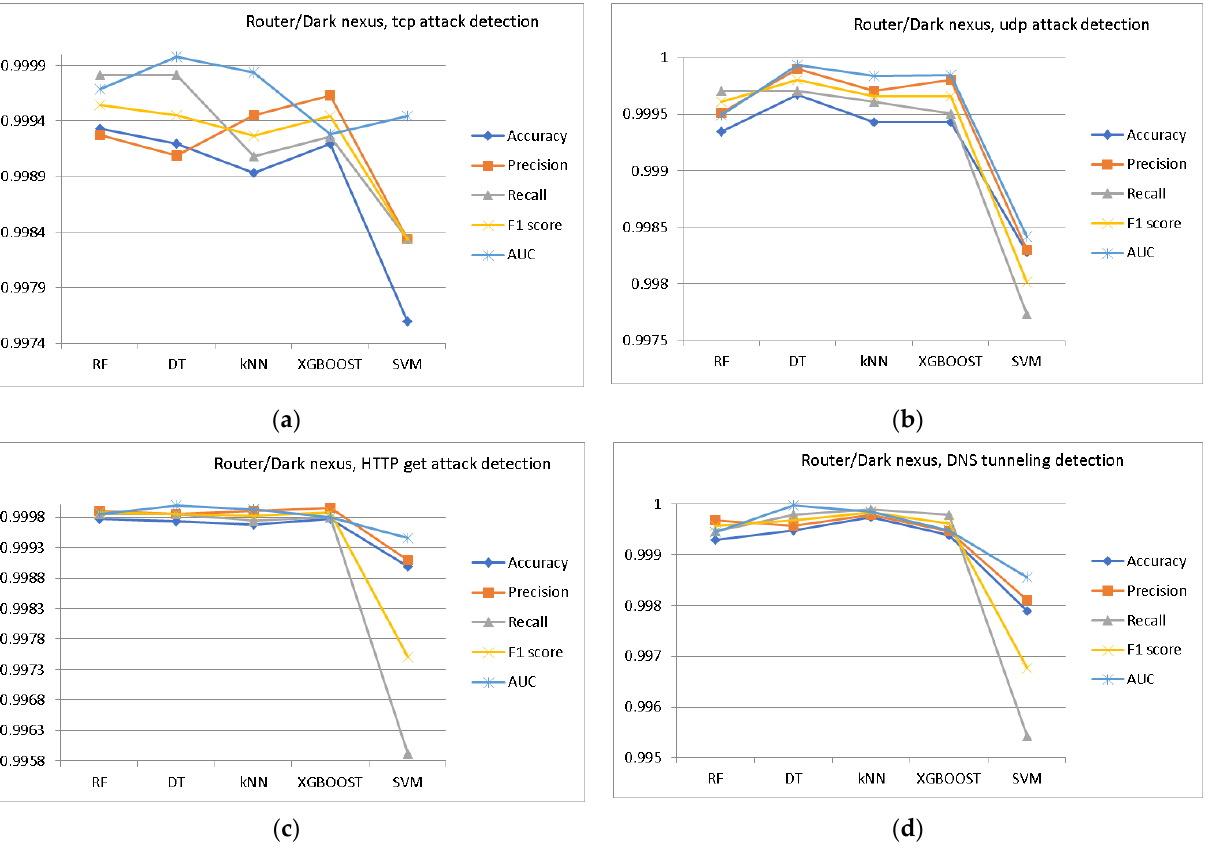
Figure 4. Comparison for different MLA efficiencies (decision tree — DT, random forest — RF, K-nearest neighbor — KNN, extreme gradient boosting — XGBoost, support vector machine — SVM) for Router/Dark Nexus botnet detection: ( a ) TCP attack; ( b ) UDP attack; ( c ) HTTP GET attack; ( d ) DNS tunneling.